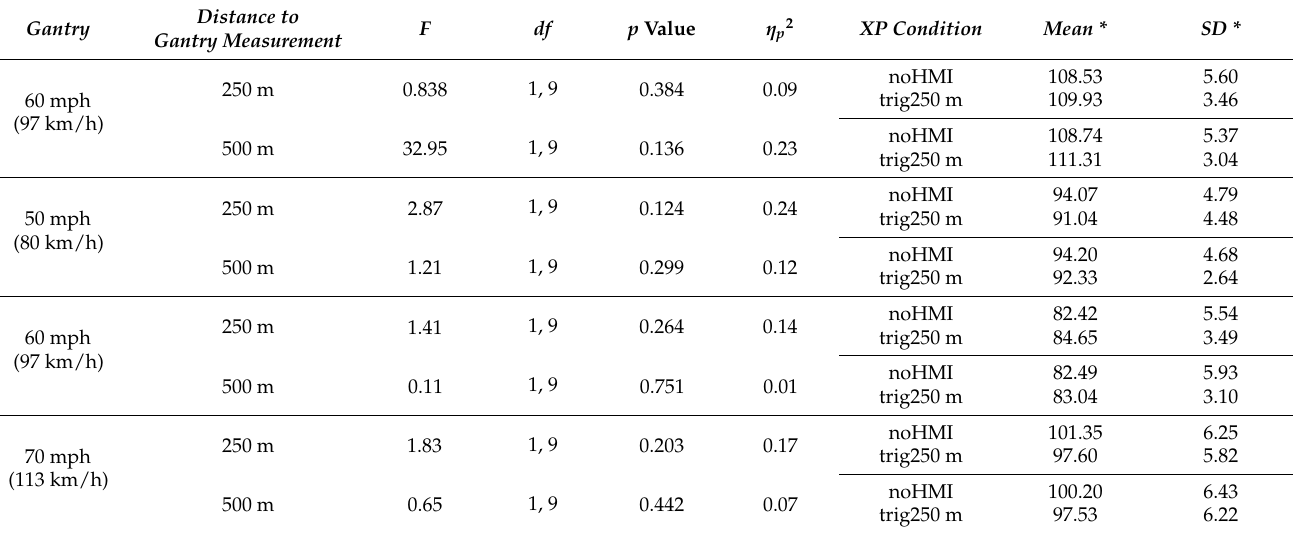
Figure 8. Graphical representation of the mean speeds (mph) in both experimental conditions. Plain lines represent the trig250 m and the noHMI condition whereas dashed lines represent the trig500 m condition. Blues lines represent the trig250 m condition, orange lines the trig500 m condition and the grey lines the noHMI condition. Significant differences within the same HMI trigger condition are circled. Table 6. Repeated measures ANOVA conducted to compare mean speeds between the noHMI and the trig250 m conditions for the same sequence of gantries. Scores reported in